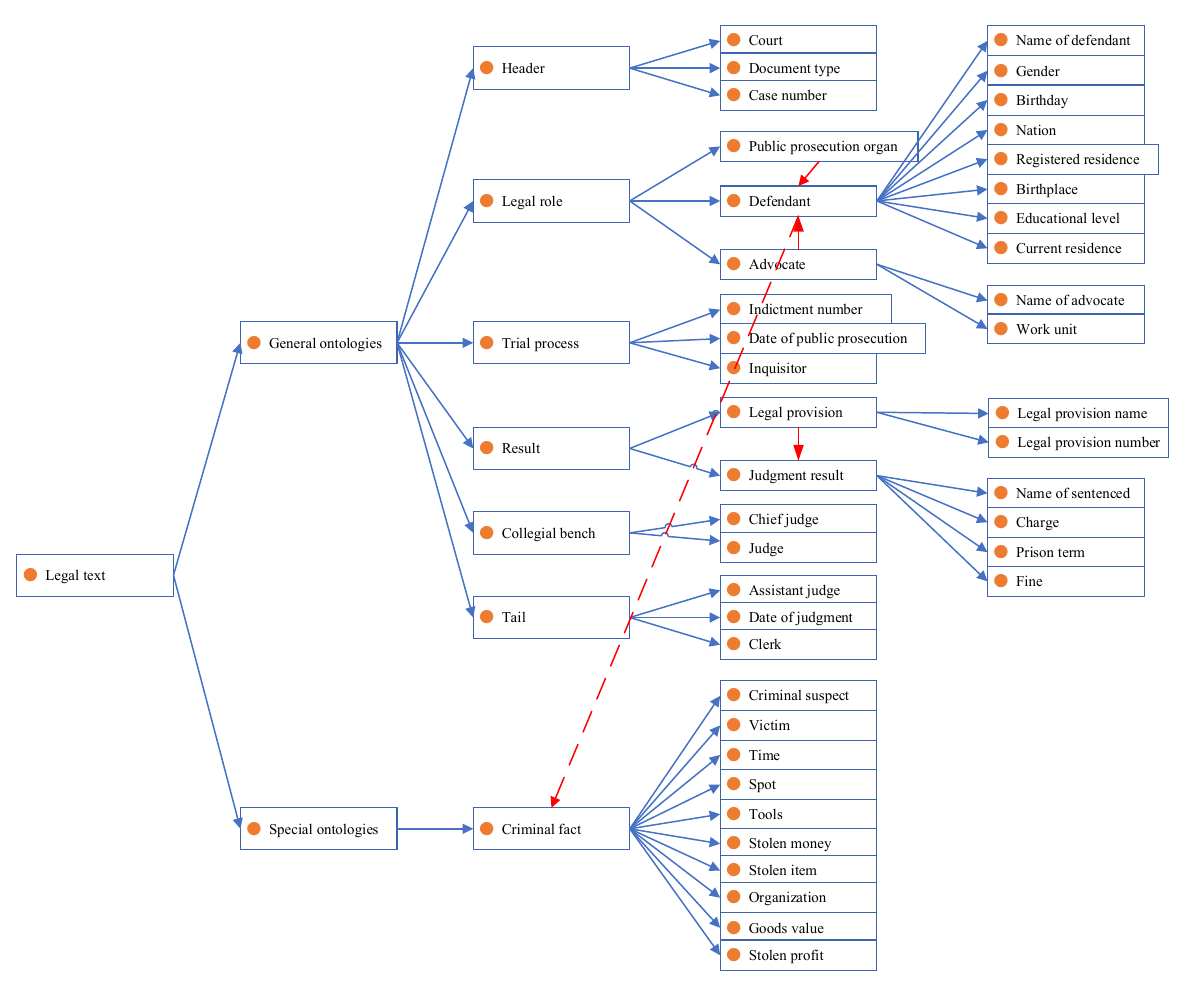
Figure 2. A snapshot of concepts in Chinese Legal Text Ontology.